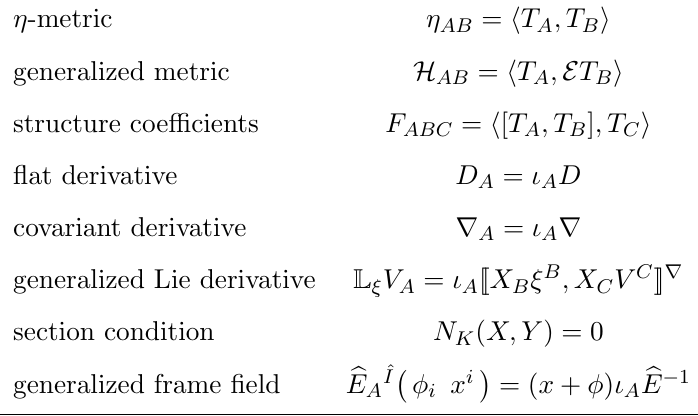
Table 2 . Relation between the crucial ingredients for the half-integrable structure on group mani- folds and DFT WZW . To simplify the notation for the generalized Lie derivative, we use the vector (cid:12)elds X A = E (cid:0) 1 T A which generate right translations on P